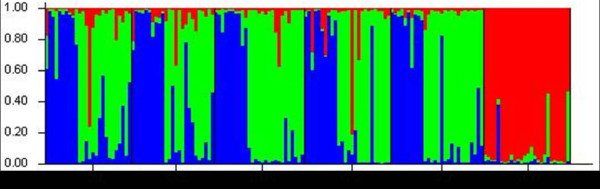
Bayesian cluster analysis using STUCTURE. Graphical representation of the data set for the most likely K (K = 3), where each color corresponds to a suggested cluster and each individual is represented by a vertical bar. The X-axis corresponds to population codes. The Y-axis presents the probability of assignment of an individual to each cluster.